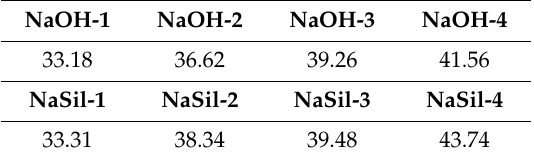
Figure 7. Sound transmission loss of the geopolymers fabricated using a ( a ) sodium hydroxide activating solution and ( b ) water glass alkaline activating solution. Table 3. The mean sound insulation value of geopolymers (dB).